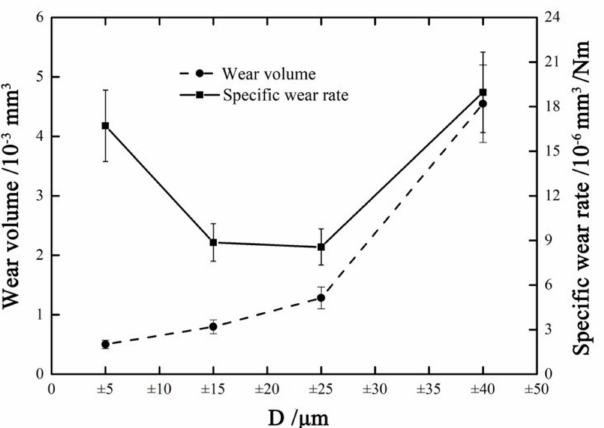
Figure 17. Wear volume and specific wear rate versus displacement amplitude with F n = 15 N, ƒ = 15 Hz, and V c = 0 V.